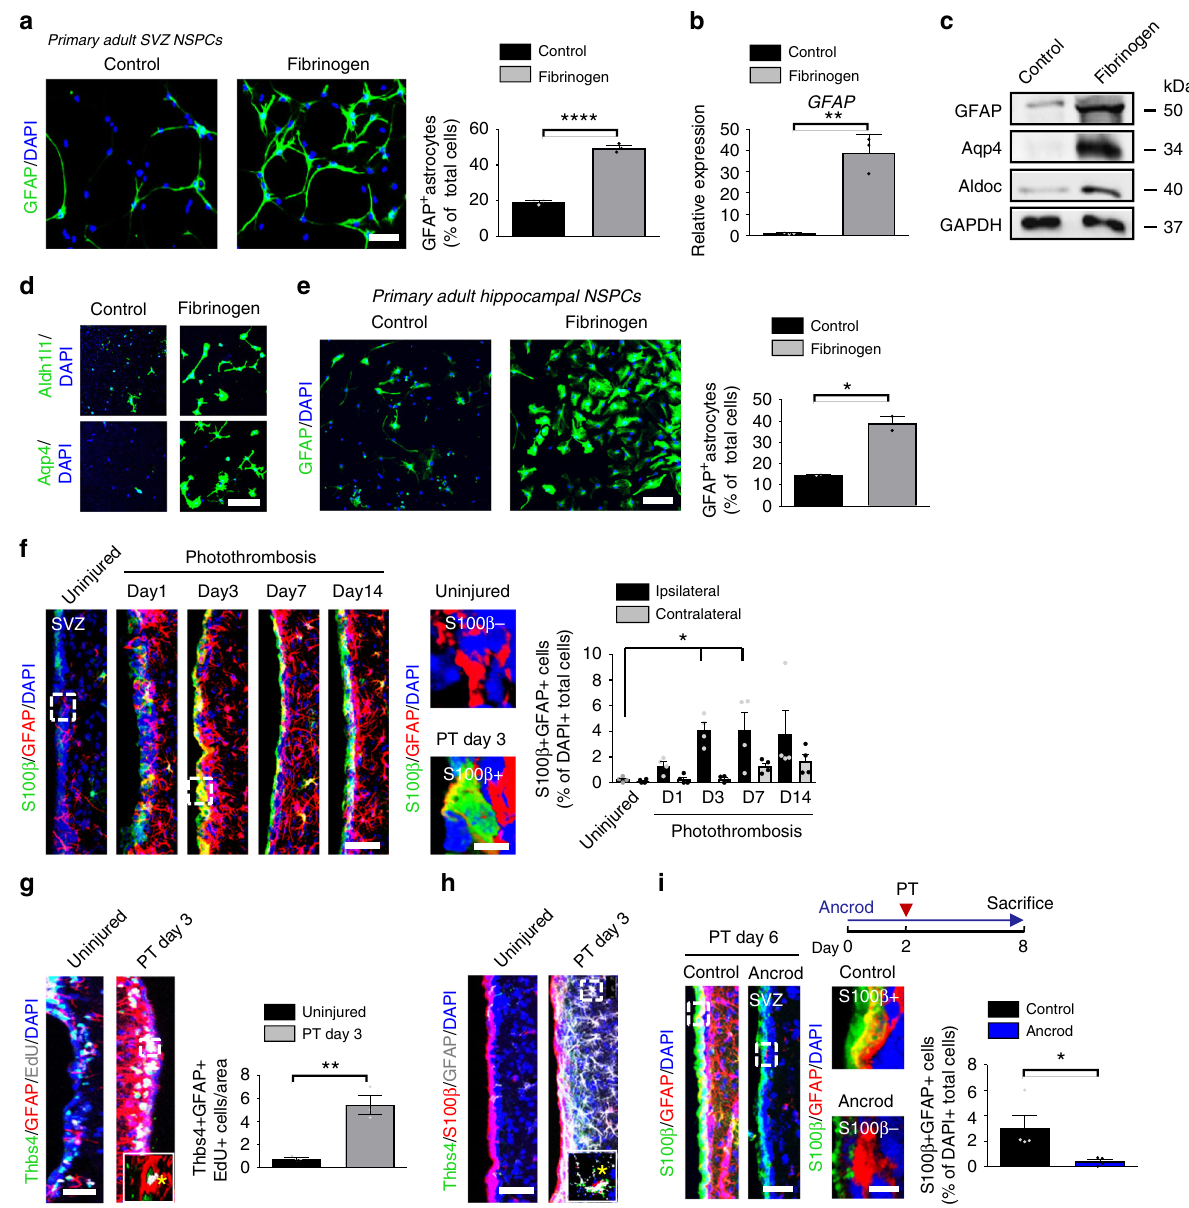
Fig. 2 Fibrinogen-induced differentiation of NSPCs into astrocytes. a GFAP + astrocytes (green) in untreated and fi brinogen ‐ treated adult SVZ-derived NSPCs. Scale bar, 56 μ m. Quanti fi cation of GFAP + astrocytes. ( n = 3, mean ± s.e.m, unpaired Student ’ s t -test, *** P < 0.001). b Expression of GFAP mRNA in NSPCs. ( n = 3, mean ± s.e.m, unpaired Student ’ s t -test, ** P < 0.01). c Immunoblot for GFAP, Aqp4, Aldoc, and GAPDH in NSPCs 2 days after fi brinogen treatment. d Aldh1l1 + (green, top) and Aqp4 + (green, bottom) astrocytes in fi brinogen ‐ treated adult SVZ-derived NSPC cultures. ( n = 3, representative images are shown). Scale bar, 67 μ m. e GFAP + astrocytes (green) in fi brinogen ‐ treated hippocampus-derived NSPC cultures. Scale bar, 104 μ m. Quanti fi cation of GFAP + astrocytes. ( n = 2, performed in duplicate, mean ± s.e.m, unpaired Student ’ s t- test, * P < 0.05. f S100 β (green) and GFAP (red) immunostainings in the SVZ at different timepoints after PT. White boxes indicate enlargement of S100 β -GFAP + (right, top) and S100 β + GFAP + (right, bottom) cells in the SVZ of uninjured and injured (PT day 3) mice, respectively. Scale bars, 40 μ m, left and 7 µ m, enlargement. Quanti fi cation of S100 β + GFAP + cells per area ( n = 4 mice, mean ± s.e.m, one-way ANOVA and Bonferroni ’ s multiple comparisons test, * P < 0.05). g EdU (grey), Thbs4 (green) and GFAP (red) immunostainings in the SVZ at 3 days after PT. White box indicates the enlargement of an EdU + GFAP + Thbs4 + DAPI + cell (right, bottom) in the SVZ 3 days after PT. Scale bar, 25 µ m. Quanti fi cation of Thbs4 + GFAP + EdU + cells in the SVZ per area. ( n = 4 mice, mean ± s.e.m, unpaired Student ’ s t -test, ** P < 0.01). h immunolabeling for Thbs4 (green), S100 β (red) and GFAP (gray) in the SVZ at 3 days after PT. White box